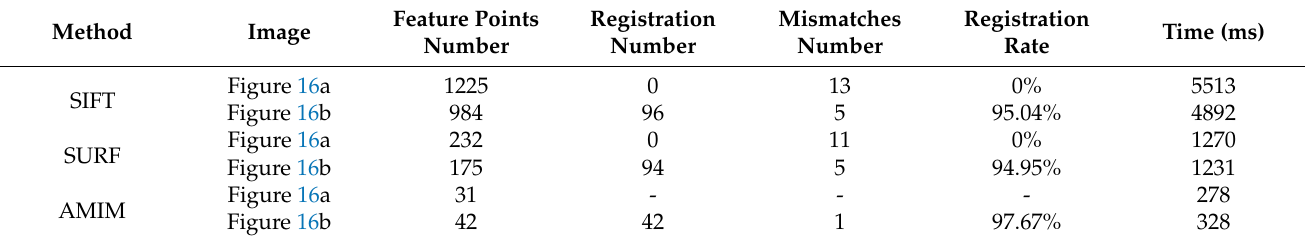
Table 5. Comparison of our method with other